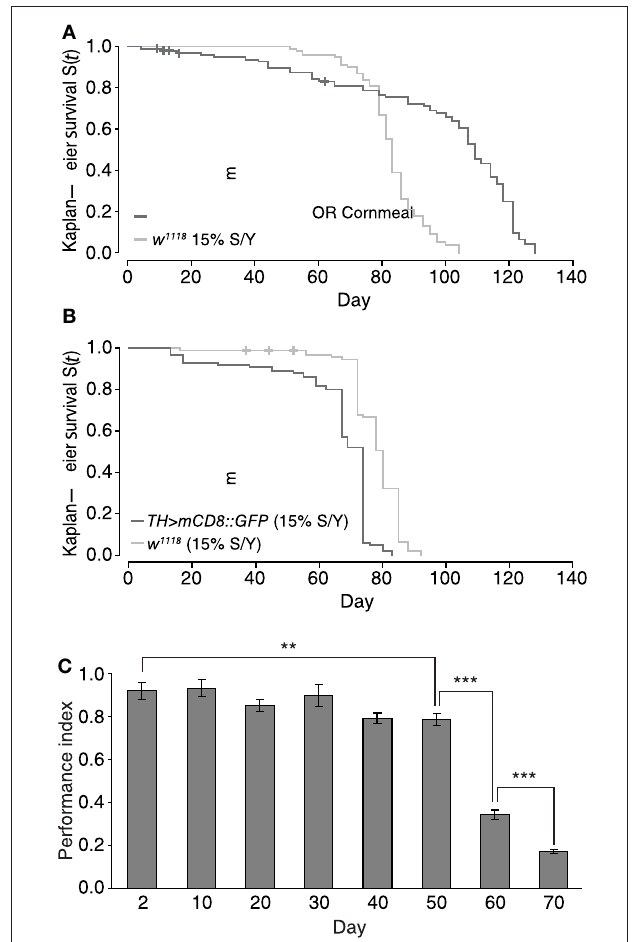
Figure 3 | Drosophila lifespan is dependent on genetic background and environment; startle-induced locomotion and negative geotaxis decline with age. (A) Kaplan–Meier survival curve of female wildtype Oregon R flies maintained on standard cornmeal media (OR cornmeal), and female w 1118 flies maintained on 15% sugar yeast (SY) media. Maximum survival of OR was 128 days (mean = 97), whereas w 1118 flies maintained on 15% SY revealed a maximum survival of 104 days (mean = 83). (B) Kaplan–Meier survival curve of heterozygous female TH > mCD8::GFP and female w 1118 flies that were maintained on 15% SY media and in an incubator with higher humidity than in (A) . Maximum survival was 83 days (mean = 66) for TH > mCD8::GFP , and 92 days (mean = 78) for w 1118 flies. (C) Startle-induced locomotion and negative geotaxis of heterozygous TH > mCD8::GFP maintained on 15% SY media; mean value of performance for consecutive days. A gradual decline can be observed from day 2 to day 50 (** p = 0.002), with a more pronounced performance decline toward the end of life between days 50, 60, and 70 (*** p < 0.001). Error bars are standard